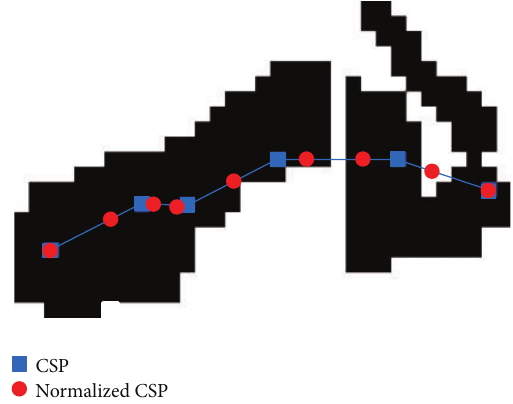
Figure 9: Two sole data that show the number of frames is different.